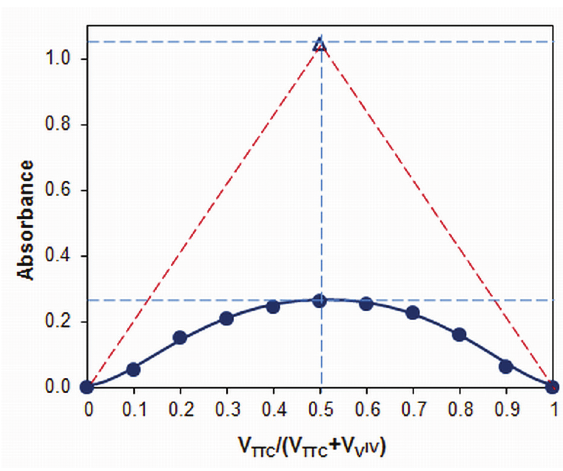
Figure 8: Liqussar-Boltz method for the determination of the conditional extraction constant ( K